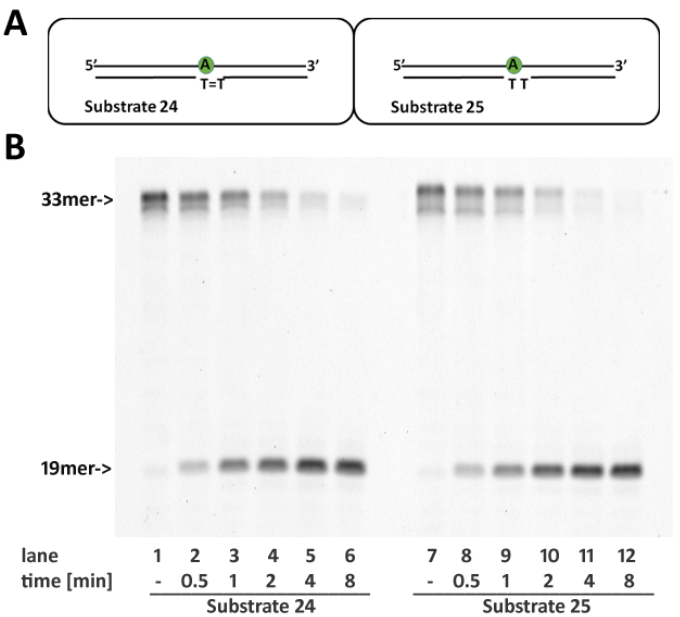
Figure 6. The presence of a CPD lesion opposite a single ribonucleotide does not affects RNase H2 activity. ( A ) Schematic representation of Substrates 24 (CTD) and 25 (TT). ( B ) Enzyme activity was compared between Substrates 24 and 25 . Time course reactions were performed as described in materials and methods using 0.4 nM RNase H2 and 20 nM Substrates 24 and 25 as indicated.